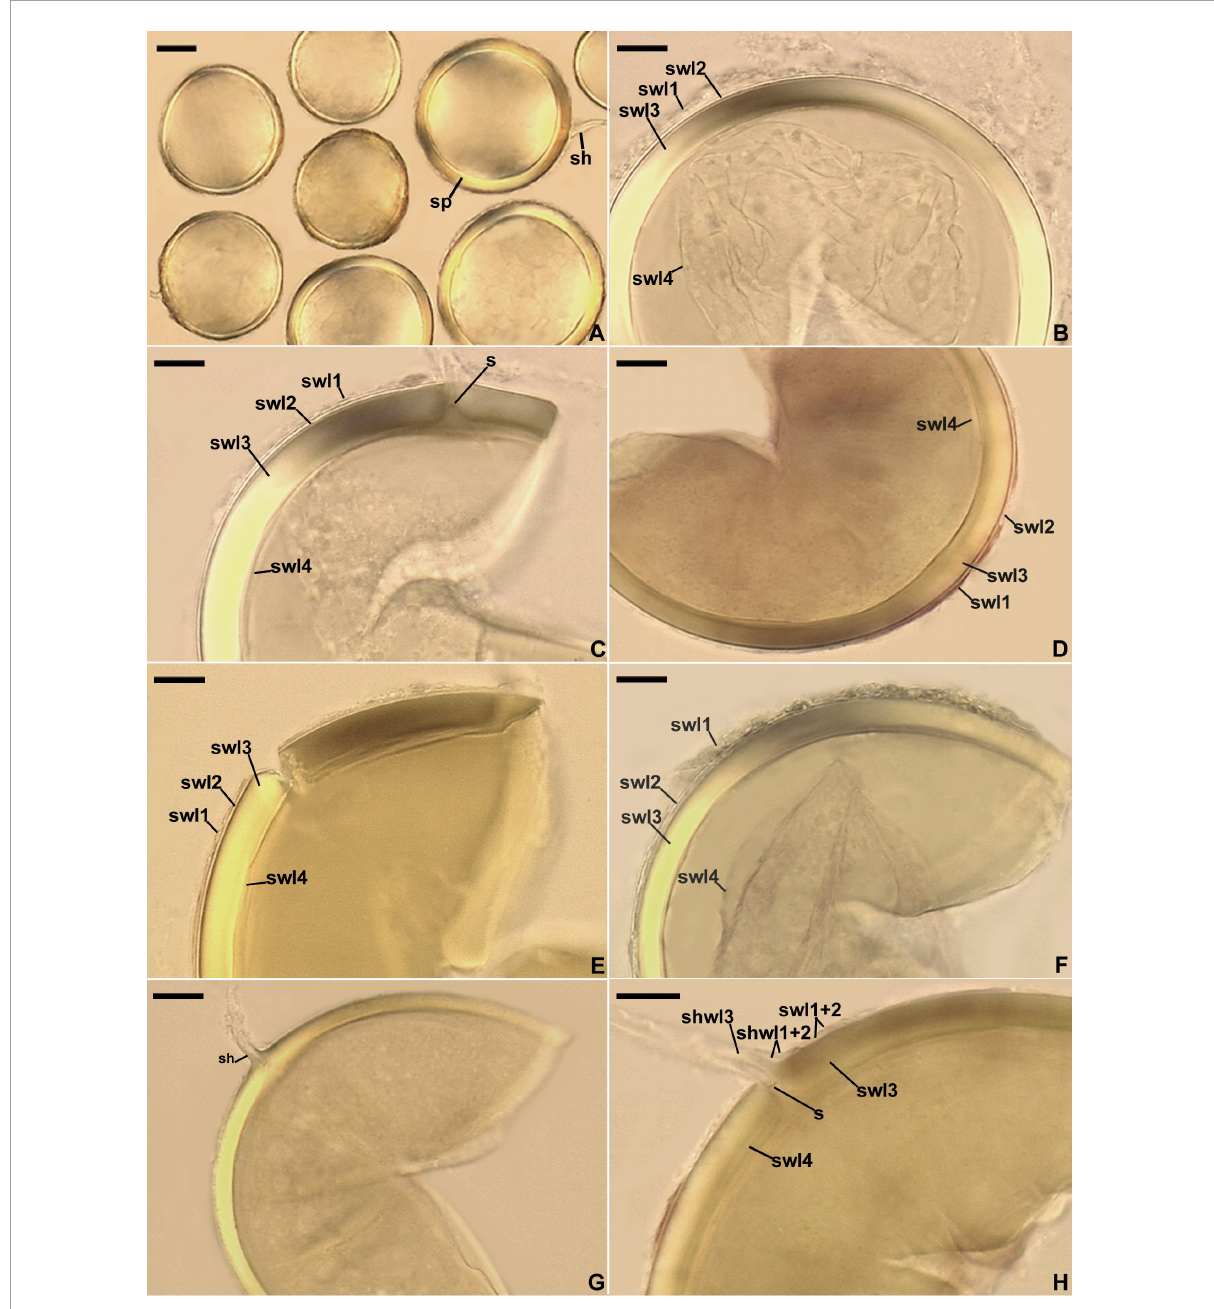
FIGURE9 Entrophospora furrazolae . (A) Intact spores (sp) with subtending hyphae (sh). (B–F) Spore wall layers (swl) 1–4; a septum (s) continuous with swl4 is indicated in (C) . (G,H) Subtending hypha (sh) with subtending hyphal wall layers (shwl) 1–3; a septum (s) continuous with swl4 is indicated in (H) . (A–C) Spores in PVLG. (D–H) Spores in PVLG+Melzer’s reagent. (A–H) Differential interference microscopy. Scale bars: (A) = 20 µ m, (B–H) = 10 µ m.